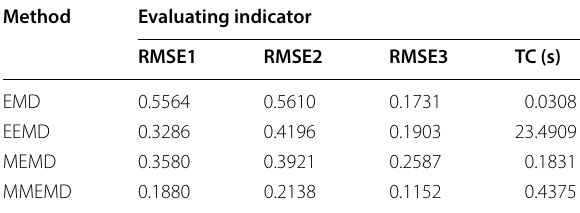
Table 2 Evaluating indicator of 3 decomposition